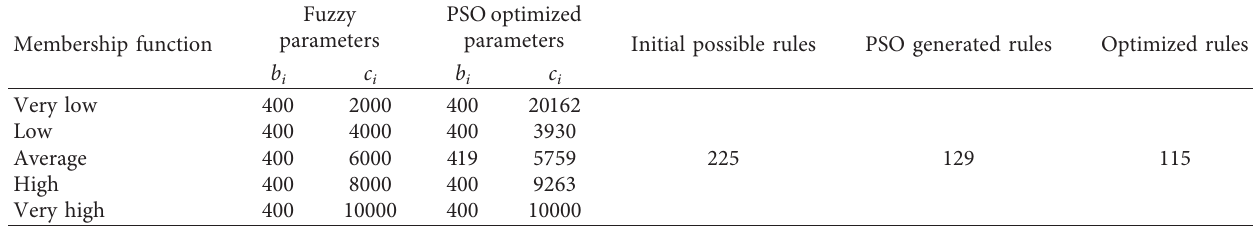
Table 6: Fuzzy-PSO optimized result of overall forecasted load for microgrid model.